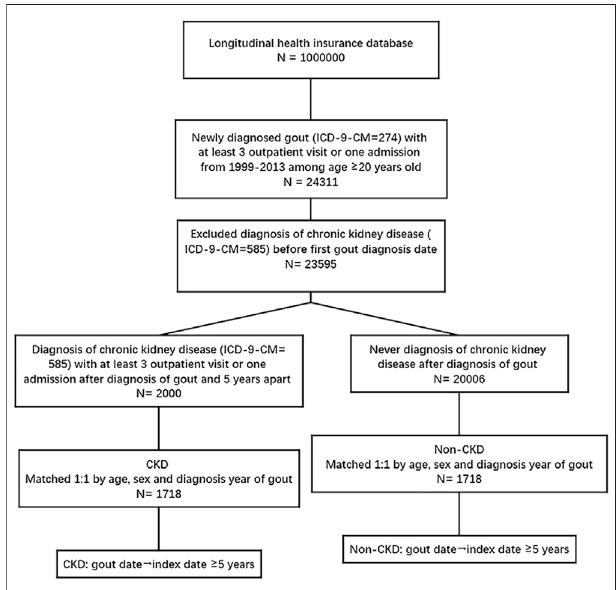
FIGURE 1 | Flow chart of the